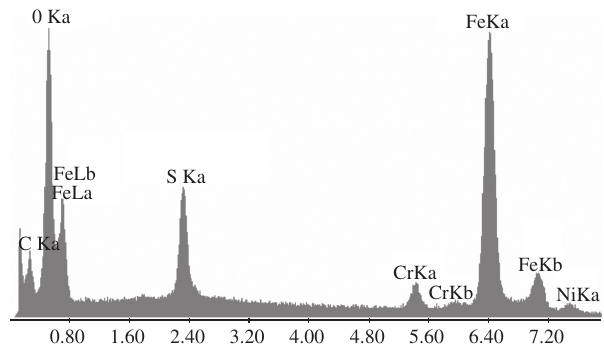
Figura 8. Chemical composition obtained by EDX analysis of the oxide layer formed on AISI 304 steel surface of the sample heat treated at 400 °C.